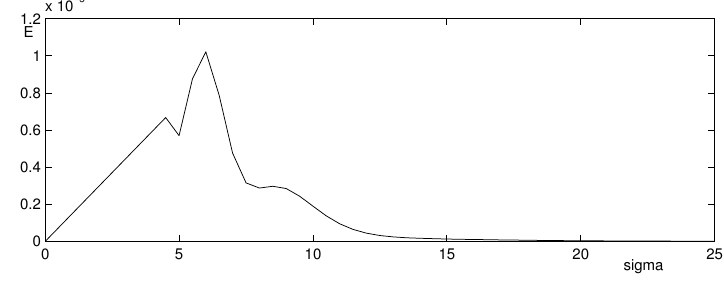
Figure 1. Lorenz system; error estimate (3.5) as a function of parameter σ